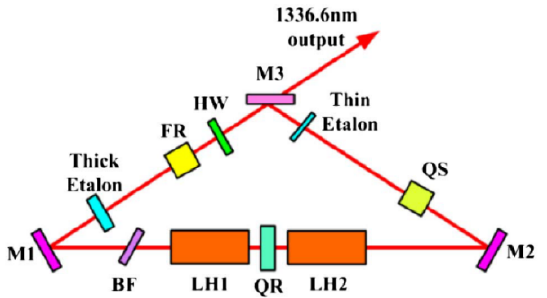
Figure 7. Experimental setup of the narrow-linewidth pulsed Nd:GYSGG ring laser at 1336 nm [35]. 2.3. Nd:GYSGG Laser Operating in the 0.9–0.95 μm